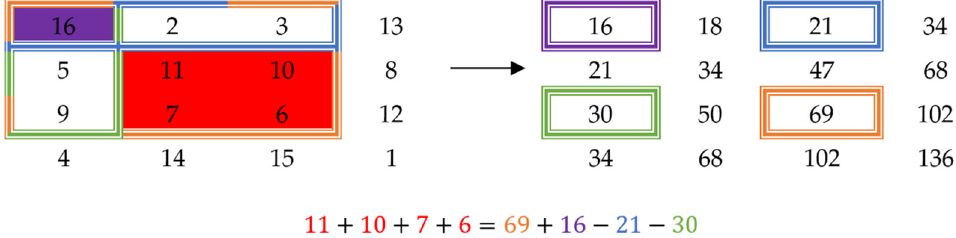
Figure 2. Example of a summed-area table ( right ) obtained from a 2D matrix ( left ).